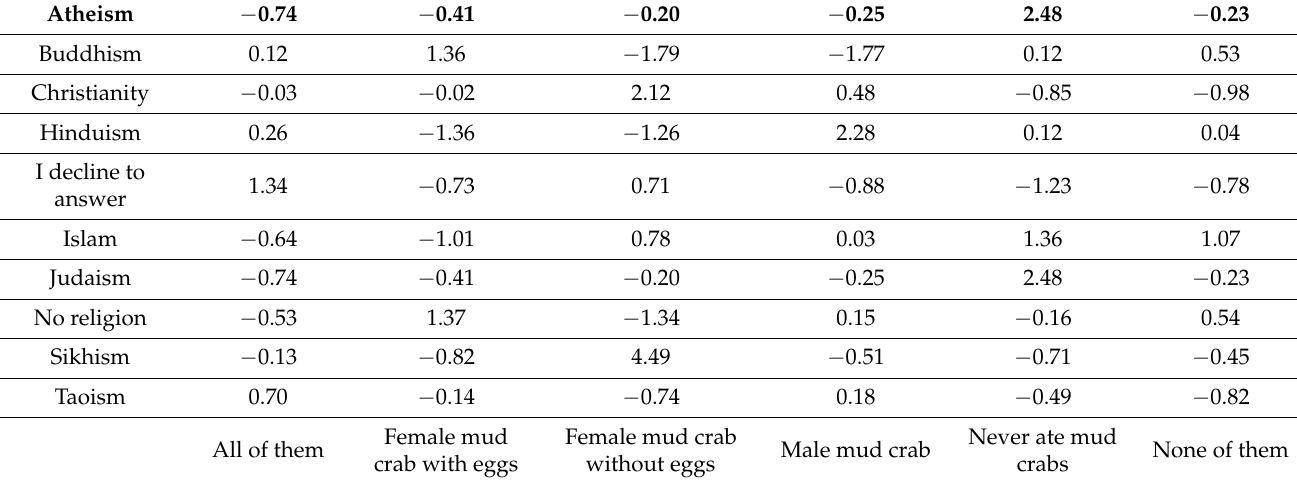
Table 6. Adjusted residual analysis between the religion and preference of consumption of mud crabs.